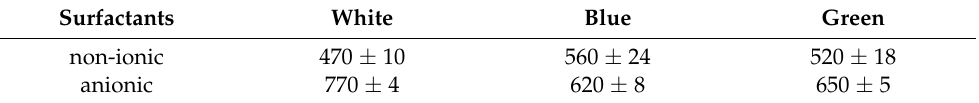
Table 4. The concentration of surfactants [mg/L] in the tested solutions of cleaning agents (0.5%).